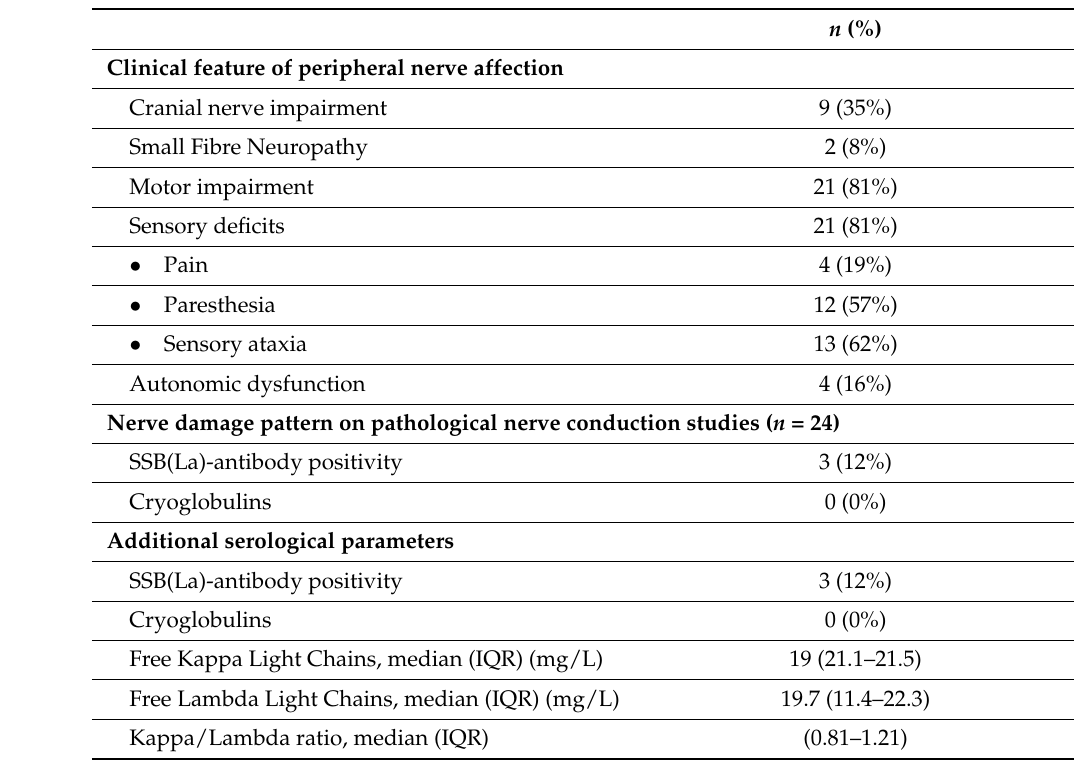
Table 3. Additional serological and clinical features of the subgroup of patients with Sjögren’s syndrome and associated